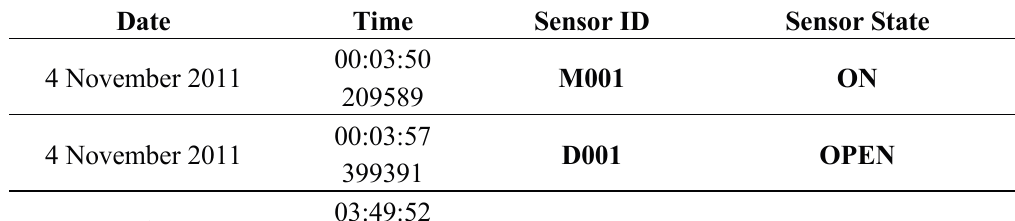
Table 1. Sensor data representation [1].